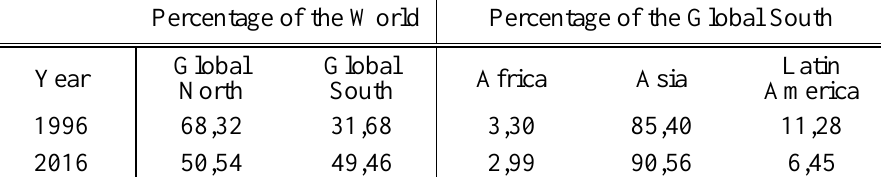
Figure 3: Government Expenditure in Research and Development Percentage per Continent Over the World R&D Investment: GN vs GS (Disaggregated) Percentage of the World Percentage of the Global South Global Global North